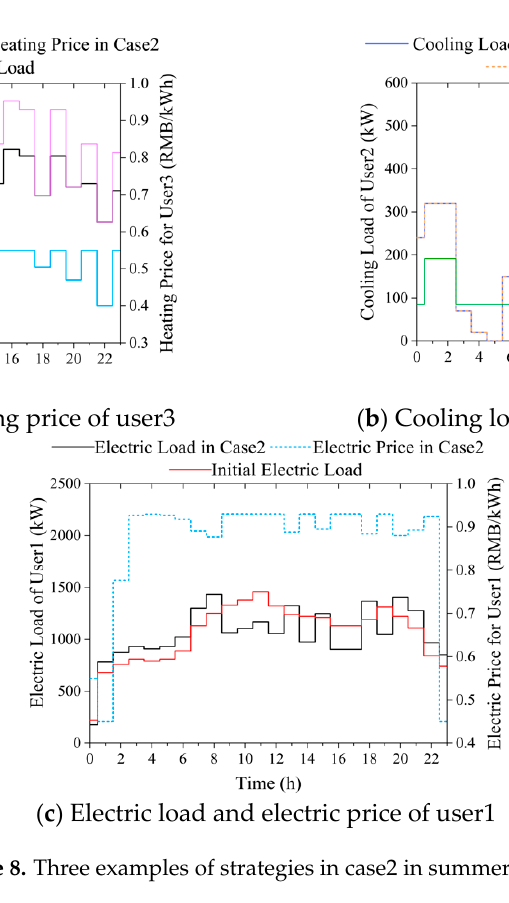
Figure 7. Pricing strategy of operator in case1 in summer.